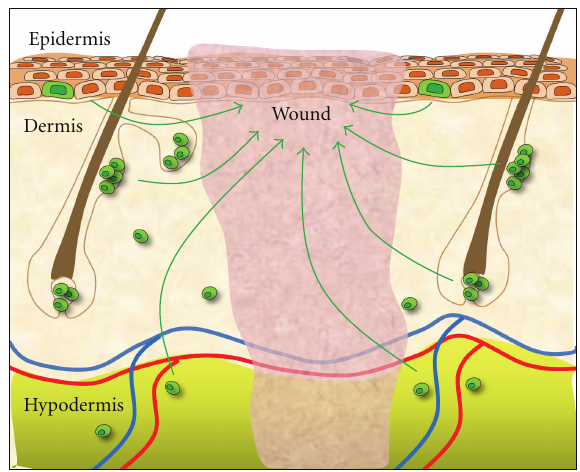
Figure 2: Locally derived skin stem cells may harbor the potential to regenerate skin. Stem cells populations have been identified in various niches throughout the skin, including the epidermal stem cell in the hair follicle bulge, sebaceous glands, and interfollicular epidermis. Dermal stem cells may exist in the dermal papilla or dermal extracellular matrix. Adipose-derived stem cells appear to be intimately associated with the perivascular